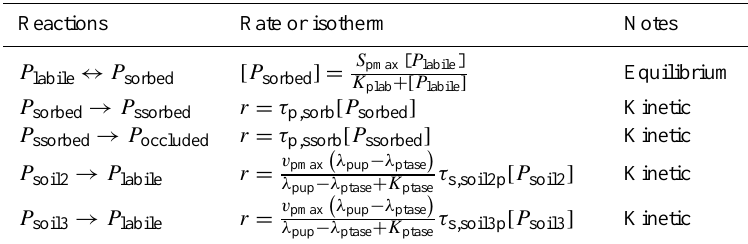
Table 4. Additional phosphorus dynamics.